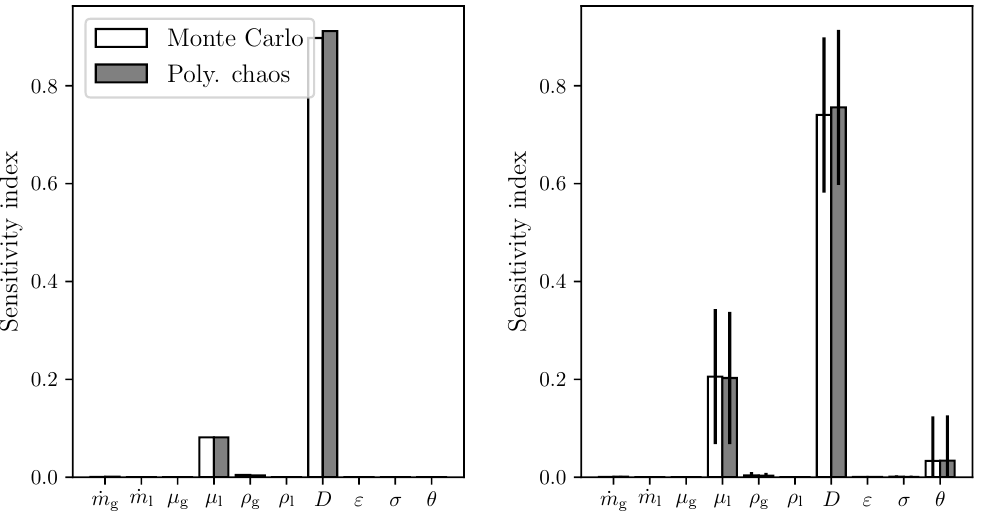
Figure 7. Pressure drop sensitivity estimates averaged over 233 experiments. ( Left ) Weighted by the variance in each experiment. ( Right ) Plain averages with standard error